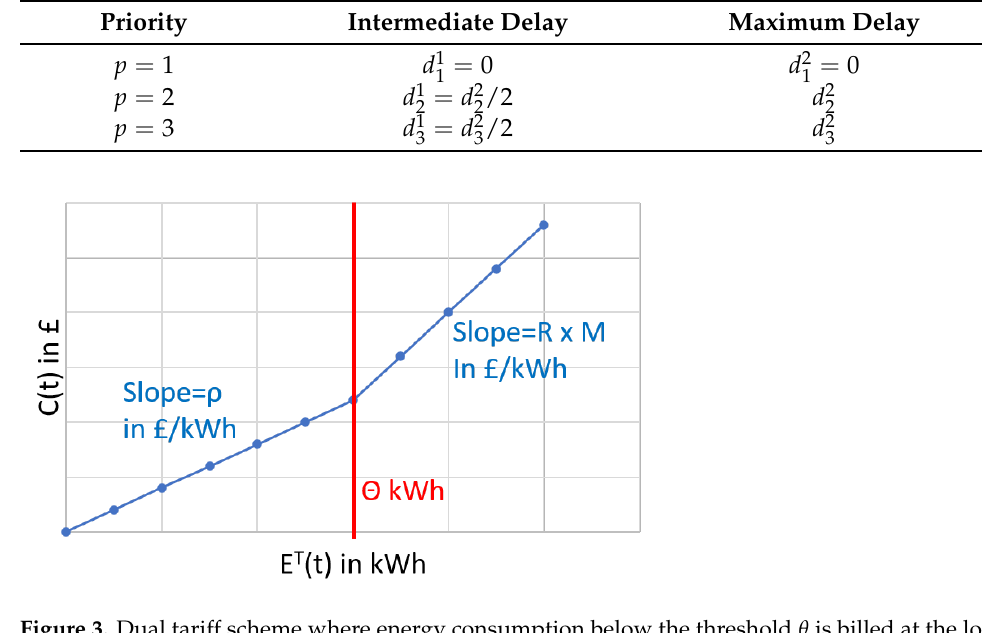
Figure 3. Dual tariff scheme where energy consumption below the threshold θ is billed at the low tariff ρ and higher consumption is billed at R × M